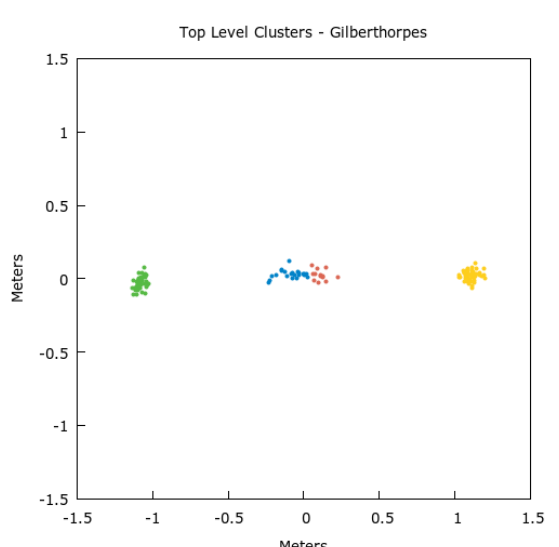
Figure 12. Example of the weaving centre conductor being split into two clusters due to it not being parallel to the span.